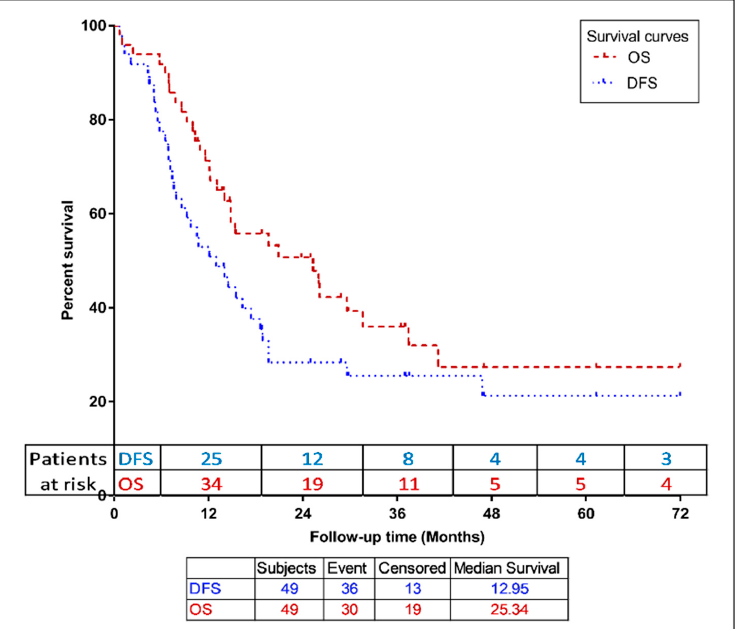
Figure 1. Kaplan–Meier curve for overall and disease-free survival in the entire study population. OS, overall survival; DFS, disease free survival.